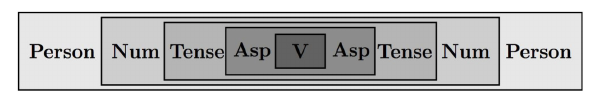
FIGURE 6 | Schematic representation of semantic composition in verbal domain.